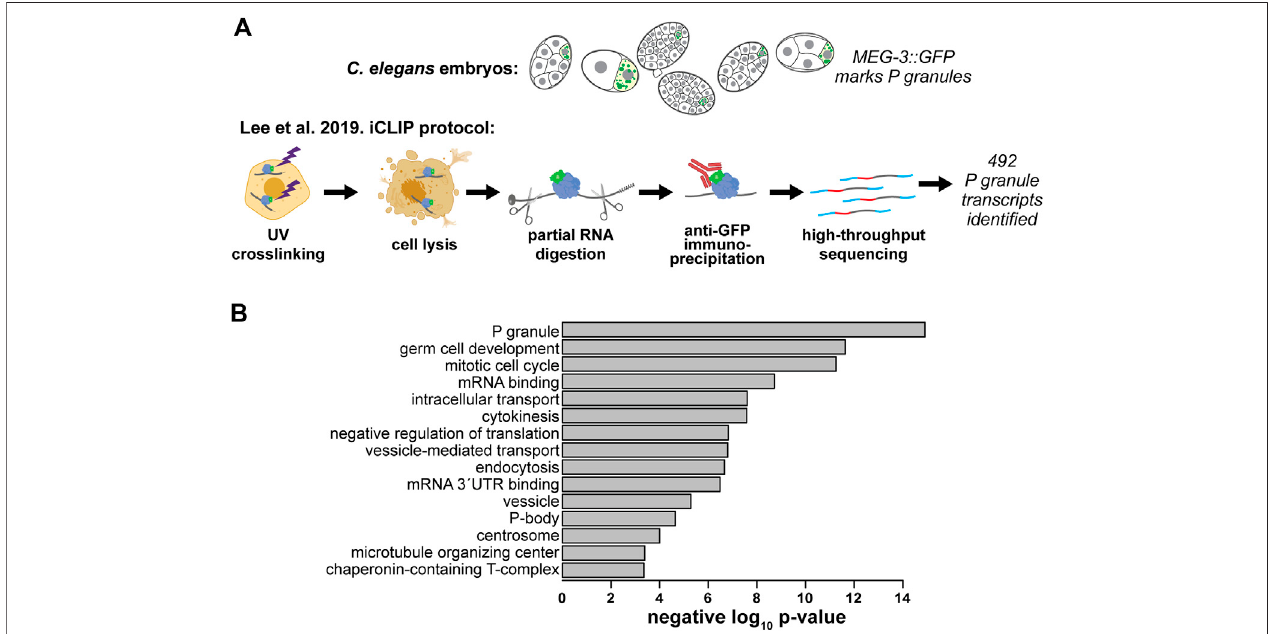
FIGURE 2 | The C. elegans P granule transcriptome has been characterized. (A) Lee et al. identi fi ed 492 transcripts enriched in P granules using an individual nucleotide resolution UV-crosslinking and precipitation (iCLIP) Lee et al. (2020a). (B) GO terms enriched in the C. elegans P granule transcriptome. We used Lee et al. ’ s expandedlistof492MEG-3-associatedPgranuletranscriptstoidentifyenrichedcategoriesusingtheGO:TermFinder(Boyleetal.,2004);Leeetal.(2020a).Transcripts withgreaterthan 10transcriptsper million at any embryonic stage from aprevious single-cell resolution RNA-seq study (Hashimshony et al., 2015) were used asa background gene set. The negative log 10 of each p value is